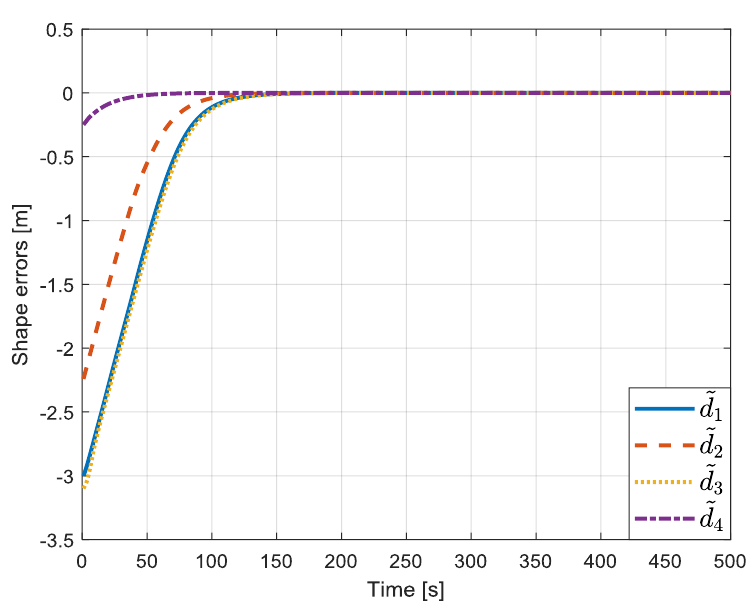
Figure 16. Shape errors of the